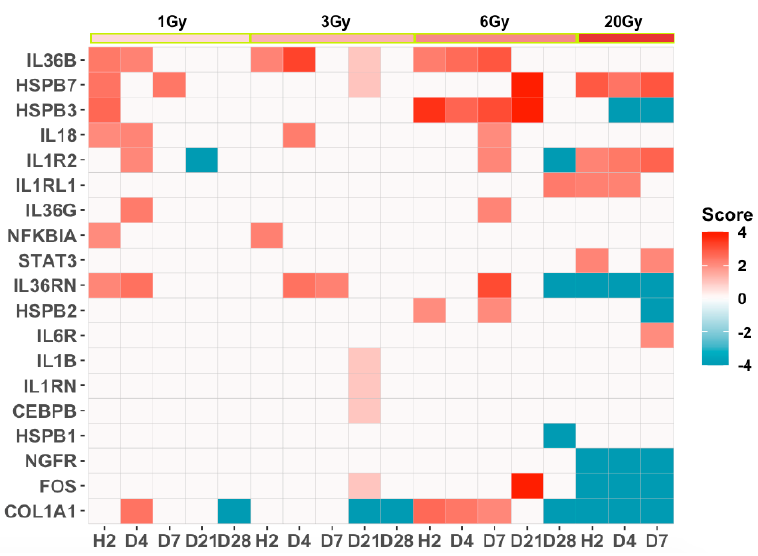
Figure 5. Heatmap of the SDTGs (FC > 2 and − log p > 1.3) enriched to the IL-6 signaling pathway. Several other genes that play an important part in hematological response and hematopathology were identified among the top differentially transcribed genes. The platelet-derived growth factor-like platelet factor 4, the leukocyte immunoglobulin-like receptor B3 ( LILRB3 ), the heme binding protein 2 ( HEBP2 ), the hemicentin 2 ( HMCN2 ), the hemoglobin subunit β ( HBB ), and the hemoglobin subunit α 1 and 2 ( HBA1/HBA2 ) genes were all downregulated sharply at all TPs after exposure to a lethal dose. Many of these genes were upregulated at different TPs after exposure to sublethal doses (Table 2). Table 2. Significantly differentially transcribed genes (SDTGs, p ≤ 0.05 and FC ≥ 2) with an impact on hematological functions. Red-filled cells indicate upregulation and green-filled cells indicate down-regulation.